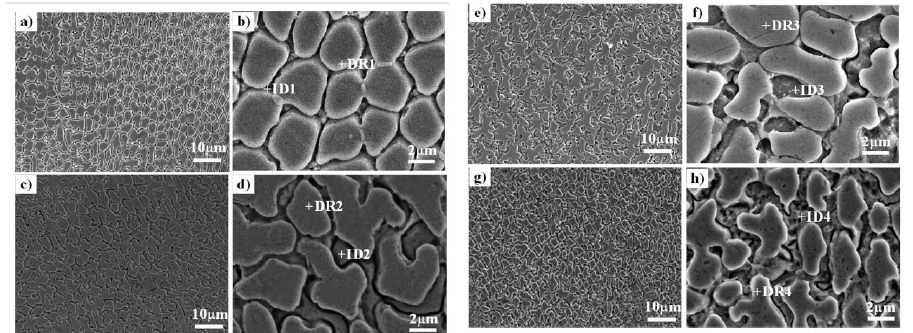
Figure 7. The microstructure of coatings with low Al content. ( a ) FeCoNiCrCu. ( b ) is the enlarged im- age for Figure 7a. ( c ) Al 0.1 CrFeCoNiCu. ( d ) is the enlarged image for Figure 7c. ( e ) Al 0.3 CrFeCoNiCu. ( f ) is the enlarged image for Figure 7e. ( g ) Al 0.5 CrFeCoNiCu. ( h ) is the enlarged image for Figure 7g. DR1, 2, 3 and 4 show the points for concentration measurements inside the dendrites. IR1, 2, 3 and 4 show the points for concentration measurements between the dendrites. Reprinted with permission from Ref. [64]. Copyright 2021